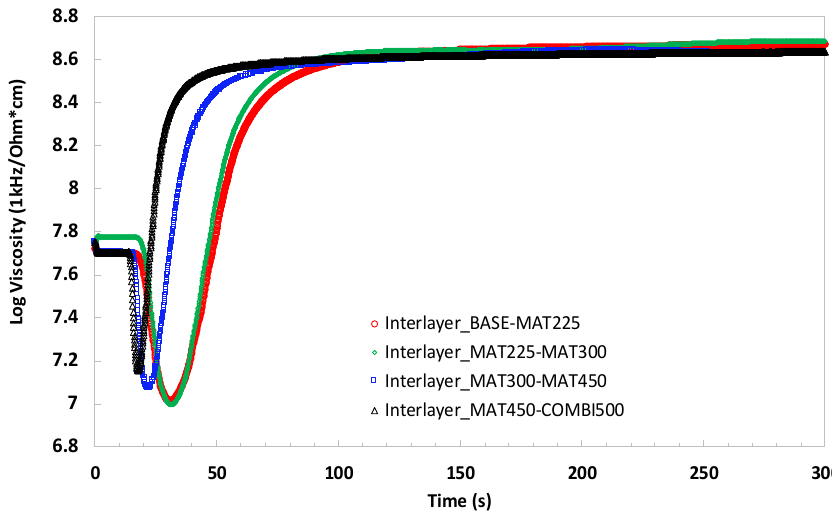
Figure 19. Log viscosity of a UV-cured composite with a 20 wt.% fibre content pressed at 2 bar. Each curve corresponds to the curing behaviour of the bottom surface of the different layers composed of MAT225 (15%), MAT300 (18%), MAT450 (20%), and COMBI500 (22%). The maximum value of the ionic viscosity measured in all the layers was the same here. This result indicated that all the layers achieved the same curing degree and were considered to reach 100% because from 150 s to 300 s, the ionic viscosity remained constant in all the layers.